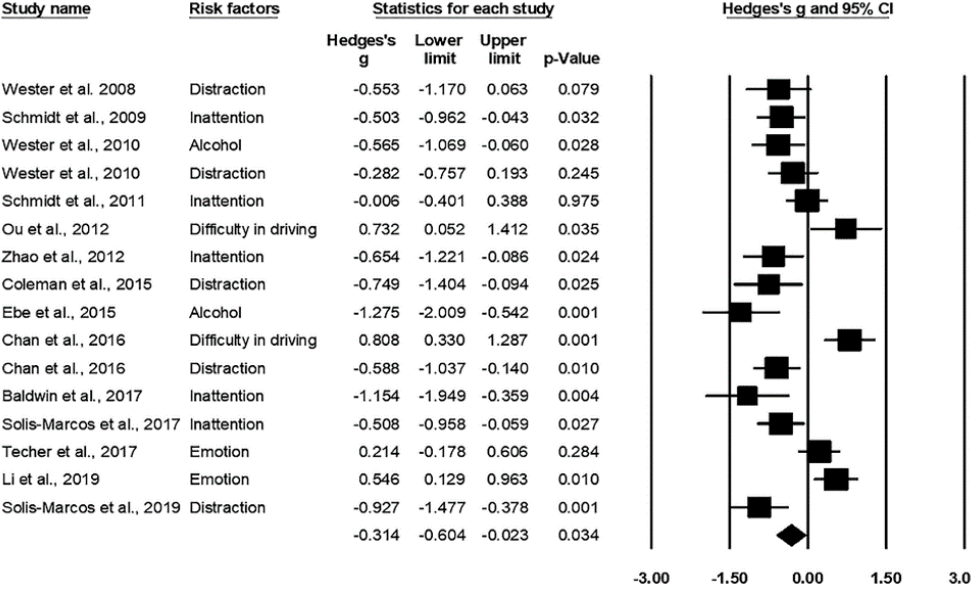
Figure 3. Forest plot for P300 amplitude in relation to the risk factors.